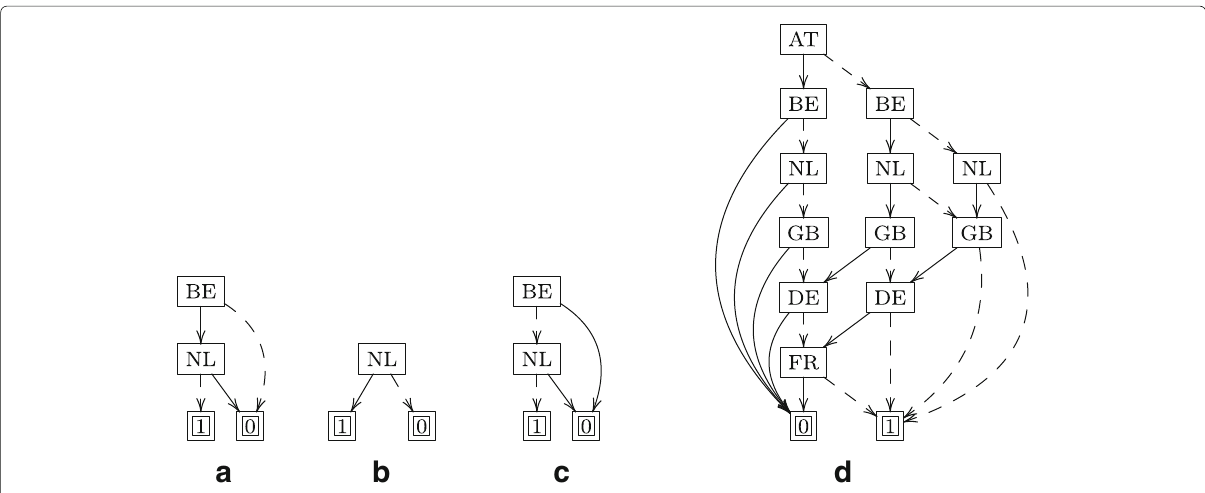
Fig. 2 BDDs ( b 1 , b 0 , b (cid:2) ) and constrained query space for the policy in “Problem statement” section. a b 1 . b b 0 . c b (cid:2) . d Constrained query